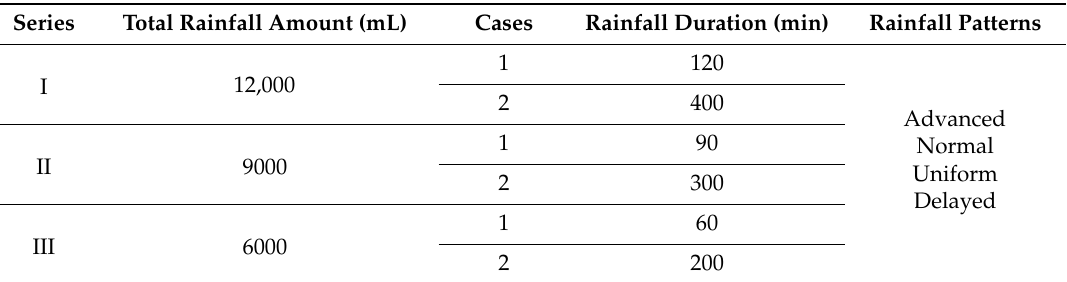
Table 3. Design of rainfall infiltration